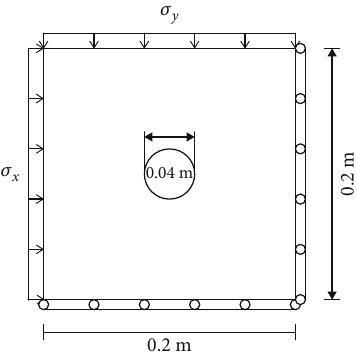
Figure 4: The numerical geometry for veri fi cation.